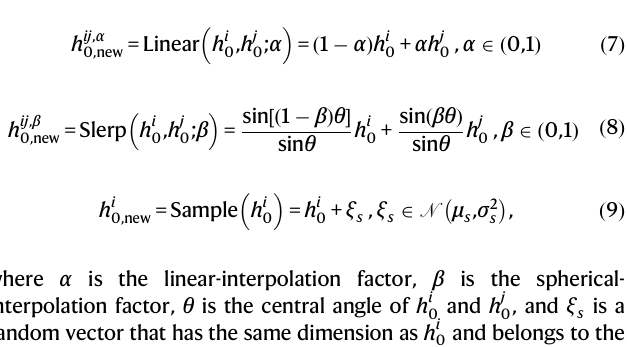
blackarrowrepresentsportalareain fl ammatorycellin fi ltration,andthebluearrow represents glomerular neutrophil in fi ltration. f Liver proteins were tested by wes- tern blot to detect RIPK1, pRIPK1, RIPK3, pRIPK3, MLKL, and pMLKL with corre- sponding antibodies. β -actin was used as an internal control. Western blot representsthreemicefromeachgroup.Molecularweight( M w)markersareshown at right. Data were obtained from two independent experiments. Source data are provided as a Source Data fi